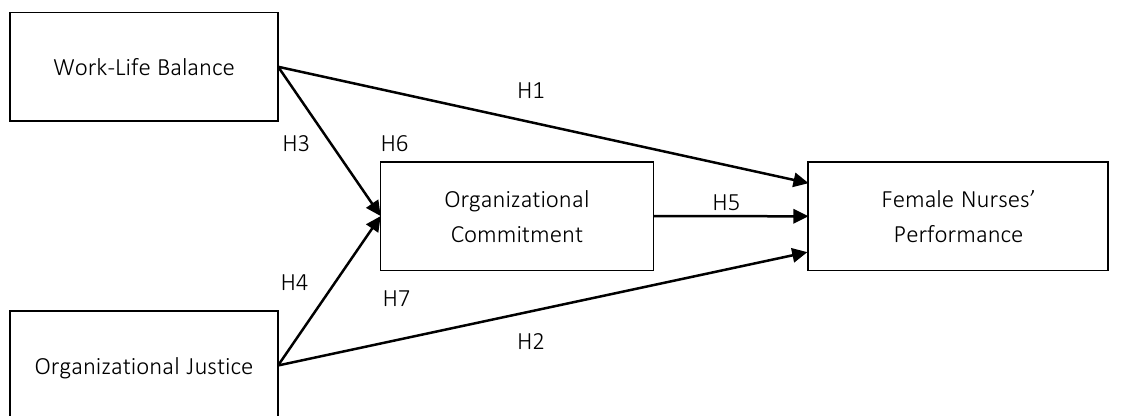
Figure 1. Conceptual